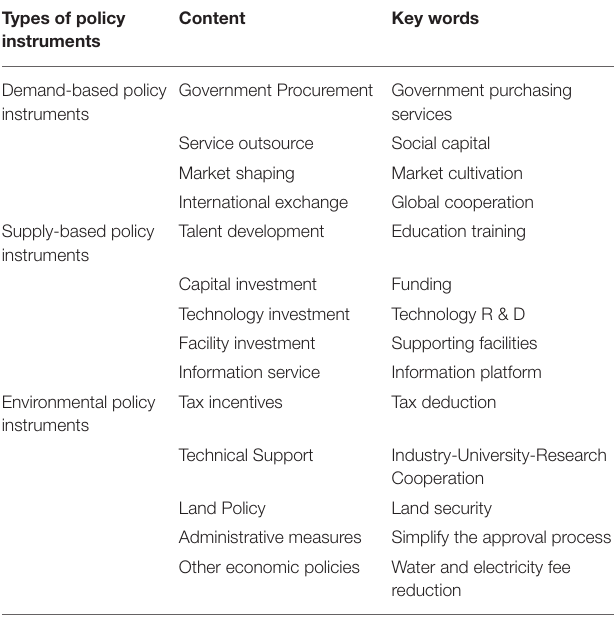
TABLE 1 | Classification and content description of policy